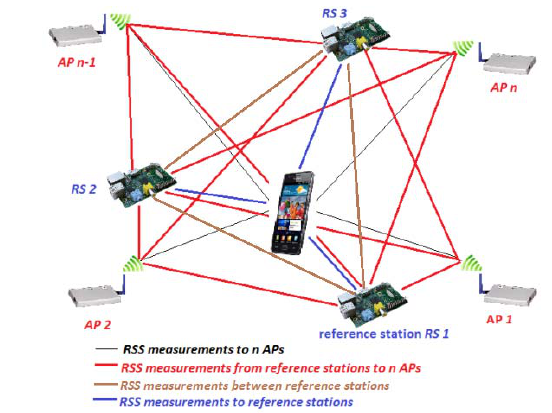
Figure 2. Network of AP and reference stations for